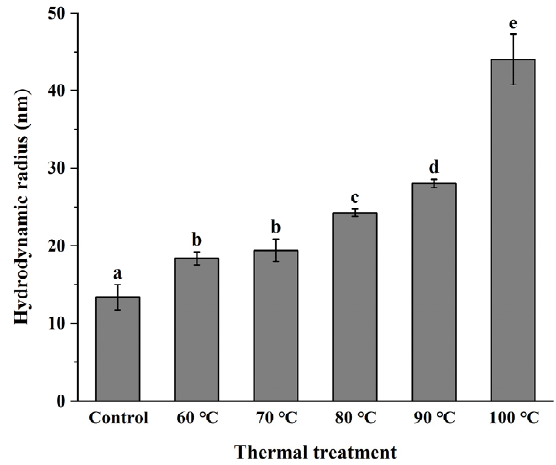
Figure 4. Effects of thermal treatment at different temperatures (untreated, 60, 70, 80, 90, and 100 ◦ C) for 10 min on the hydraulic radius of ferritin. Values with different letters are significantly different ( p < 0.05).